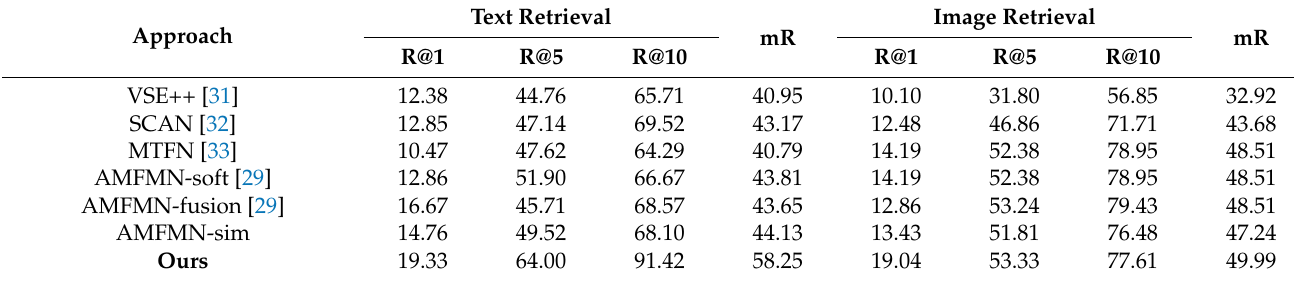
Table 6. Comparison between the state-of-the-art retrieval methods in the Merced dataset in terms of R@K.